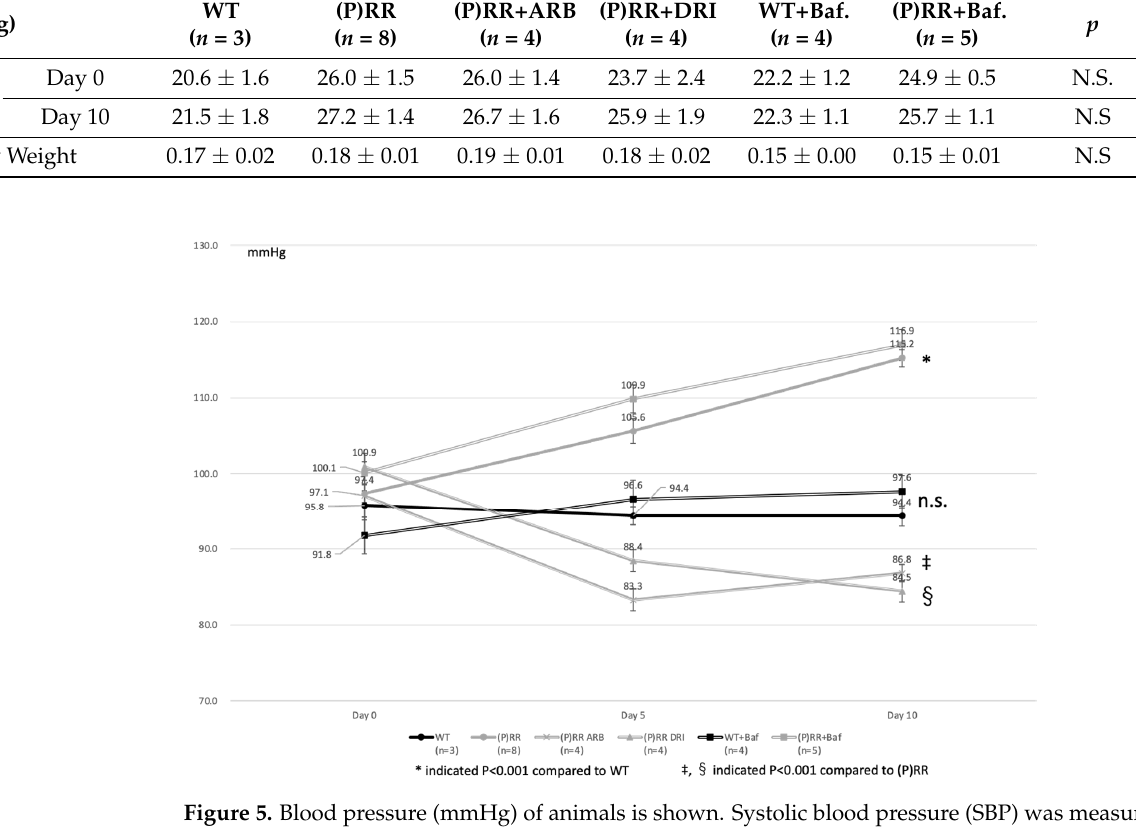
Figure 5. Blood pressure (mmHg) of animals is shown. Systolic blood pressure (SBP) was measured using the tail-cuff method on days 0, 5, and 10 with a non-invasive BP monitor (MK-2000, Muromachi Kikai Co., Ltd., Osaka, Japan). Data were analyzed using one-way ANOVA between (P)RR mice and t -test between WT and (P)RR mice. “n.s.” means “there is no significant difference between blood pressure of WT and that of